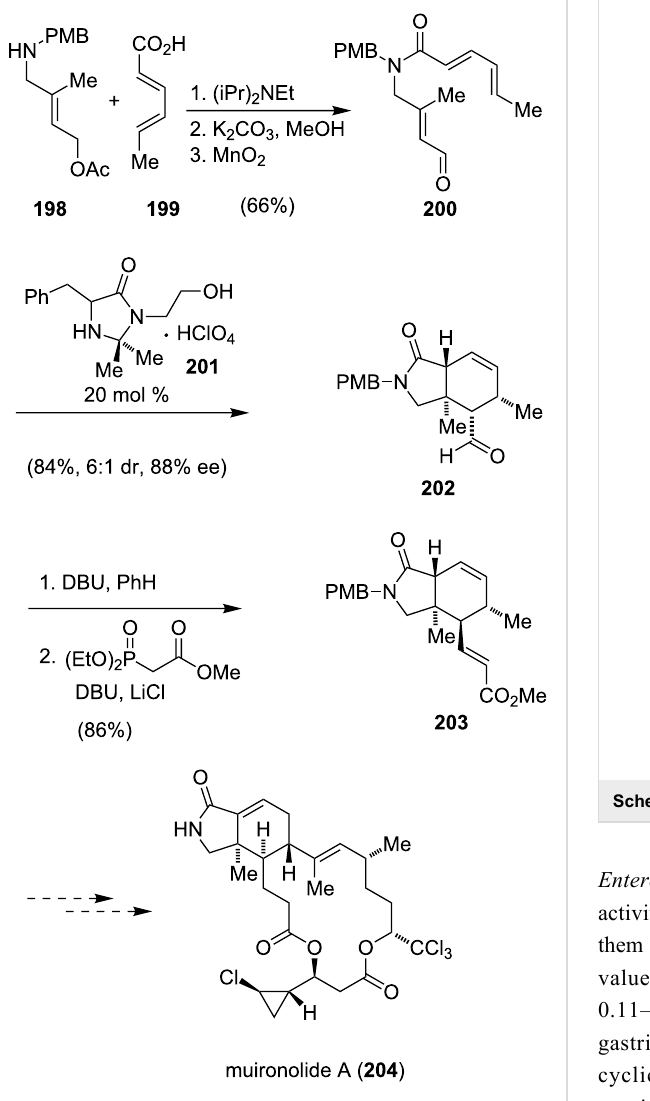
Scheme 26: Preparation of the isoindoline core of muironolide A ( 204 ).